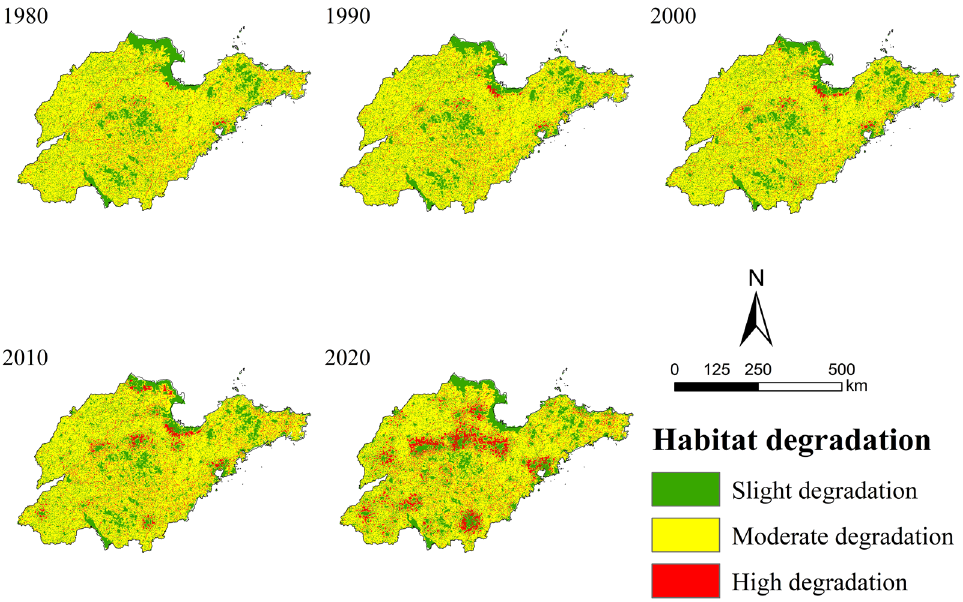
Figure 5. Distribution map of habitat degradation in Shandong Province from 1980 to